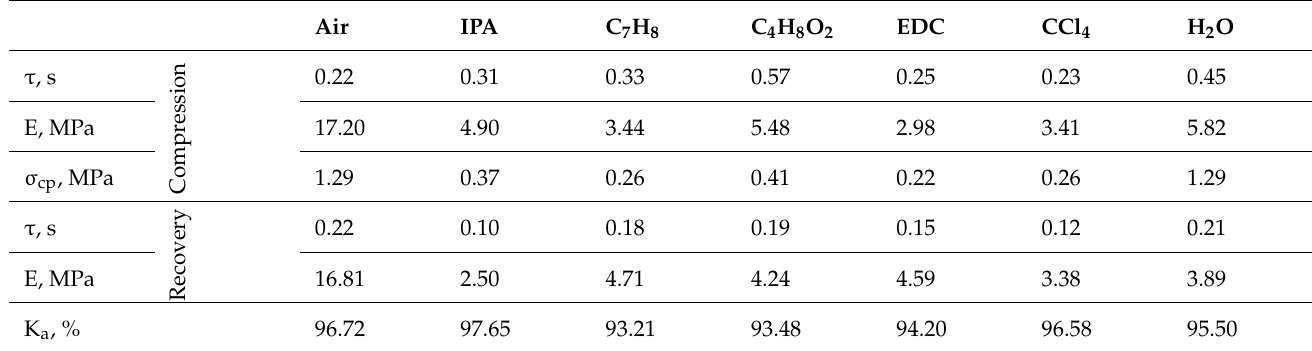
Table 3. Physical properties of the ‘composite–liquid’ system for the 3610 (NBR) blanket.